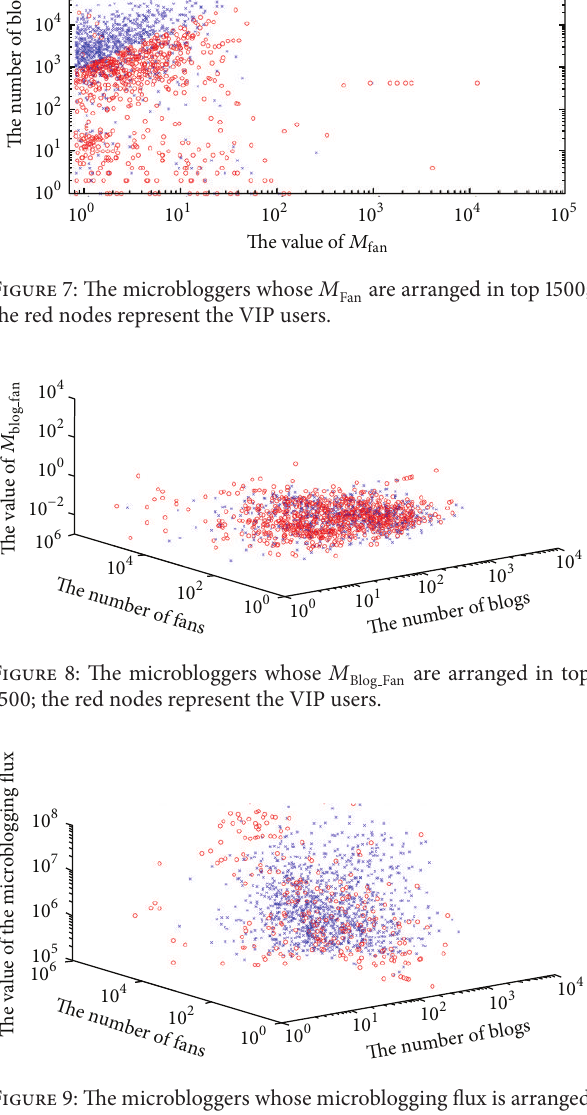
Figure 9: The microbloggers whose microblogging flux is arranged in top 1500; the red nodes represent the VIP users.